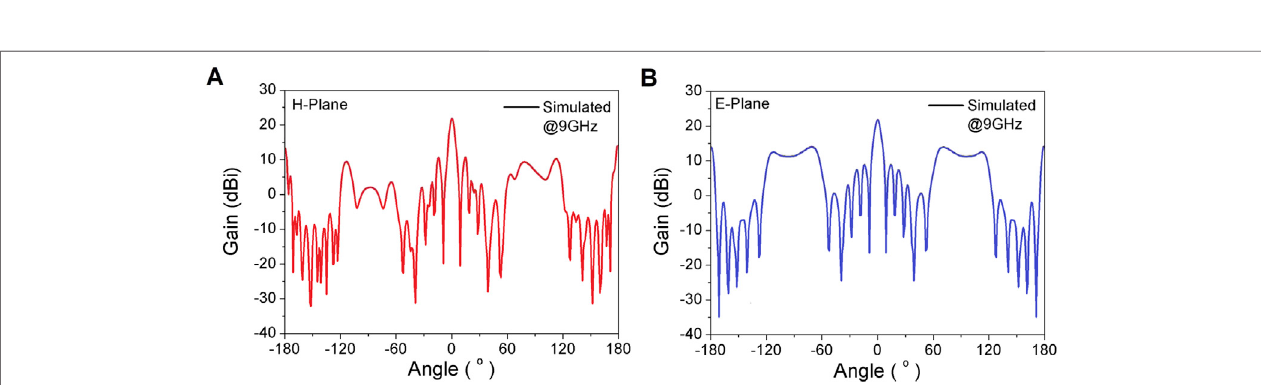
FIGURE 3 | Simulated radiation properties of the MNM antenna with a single metallic patch as the radiation source at 9.0 GHz. (A) H-plane and (B) E-plane.